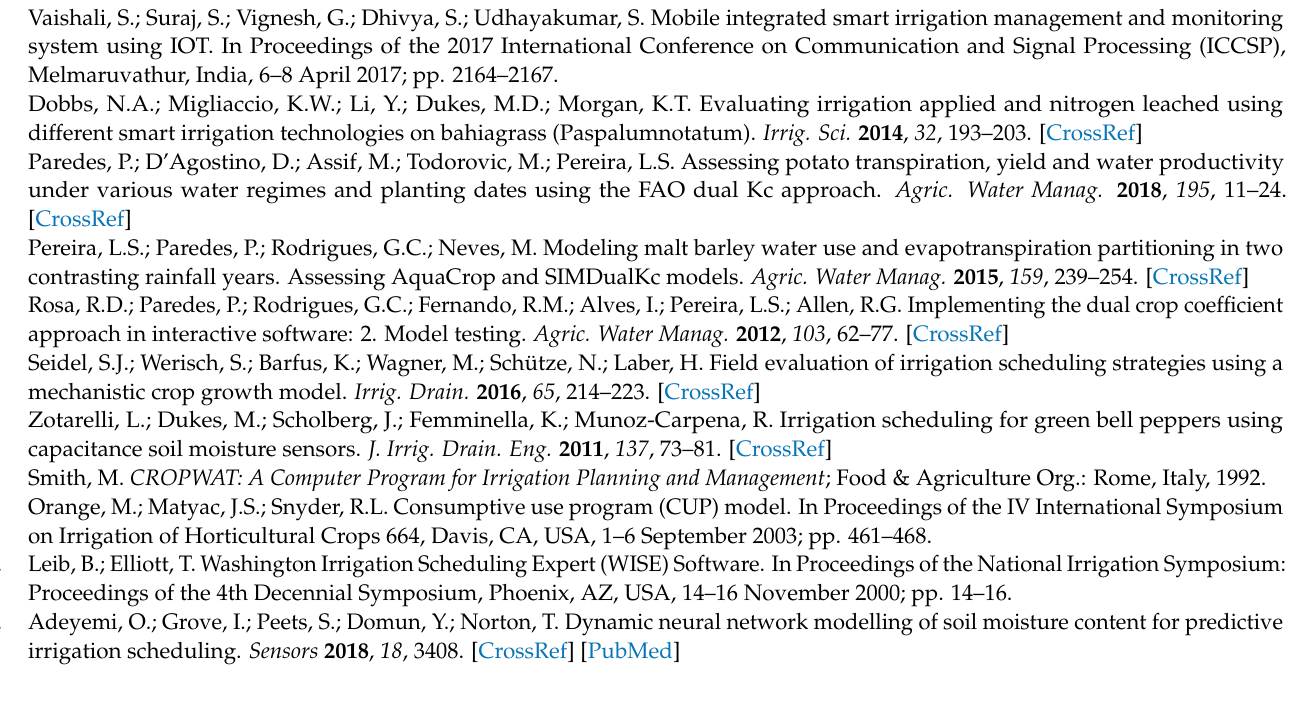
Figure A2. Accuracy statistics of AgSAT ETref comparison with station ETref at the 18 studied sites by climate.